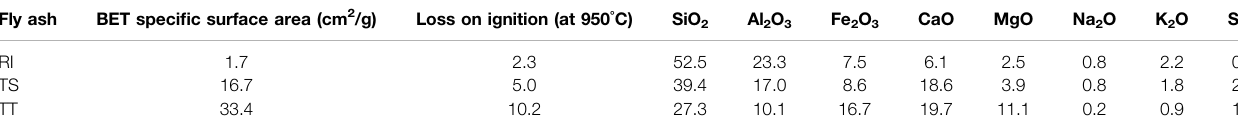
TABLE 1 | BET speci fi c surface area and chemical composition of the different types of fl y ash (wt%) which were used in the study of alkali-activated foams. Fly ash BET speci fi c surface area (cm 2